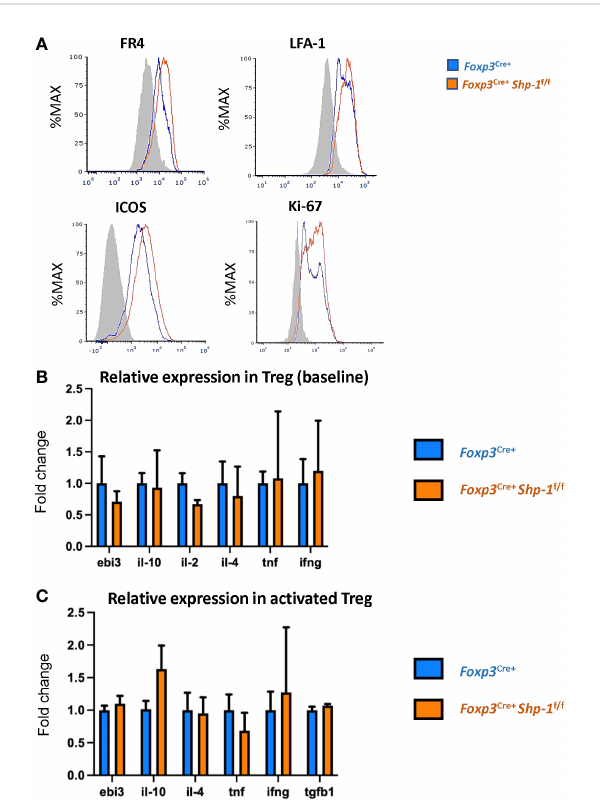
FIGURE 2 Phenotypic analyses of 6-8 weeks old Foxp3 Cre+ Shp-1 f/f and Foxp3 Cre+ control mice . (A) Histograms depict representative protein expression levels of live splenic CD4+ FOXP3+ cells as assessed by fl ow cytometric analyses. Data are gated: singlets → live cells → CD3 → CD4 → Foxp3. Statistical analyses of the MFIs (geometric mean) were performed using a two-way ANOVA test (FR4 – p=0.03878; LFA-1 – p=0.0154; ICOS – p=0.0133; Ki67 – p=0.0096) ( B , C ) Relative cytokine expression of (B) freshly isolated and (C) stimulated splenic CD4+CD25+ Treg cells isolated from 6-8 weeks old mice of the indicated genotypes, (B) n = 3 for each genotype. (C) n= 5 for stimulated Treg. (C) Treg cells were incubated for 14-18 hrs. with plate bound anti-CD3 (150 ng/ml) and soluble anti-CD28 (500 ng/ml). Error bars represent